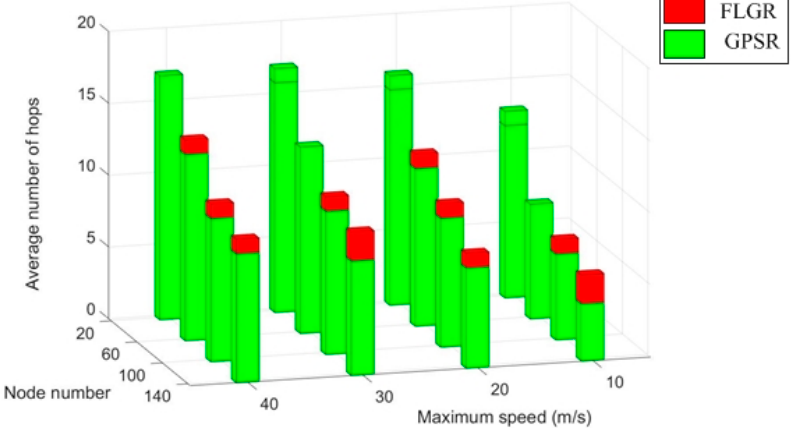
Figure 8. Comparison of average number of hops between FLGR and greedy perimeter stateless routing (GPSR).